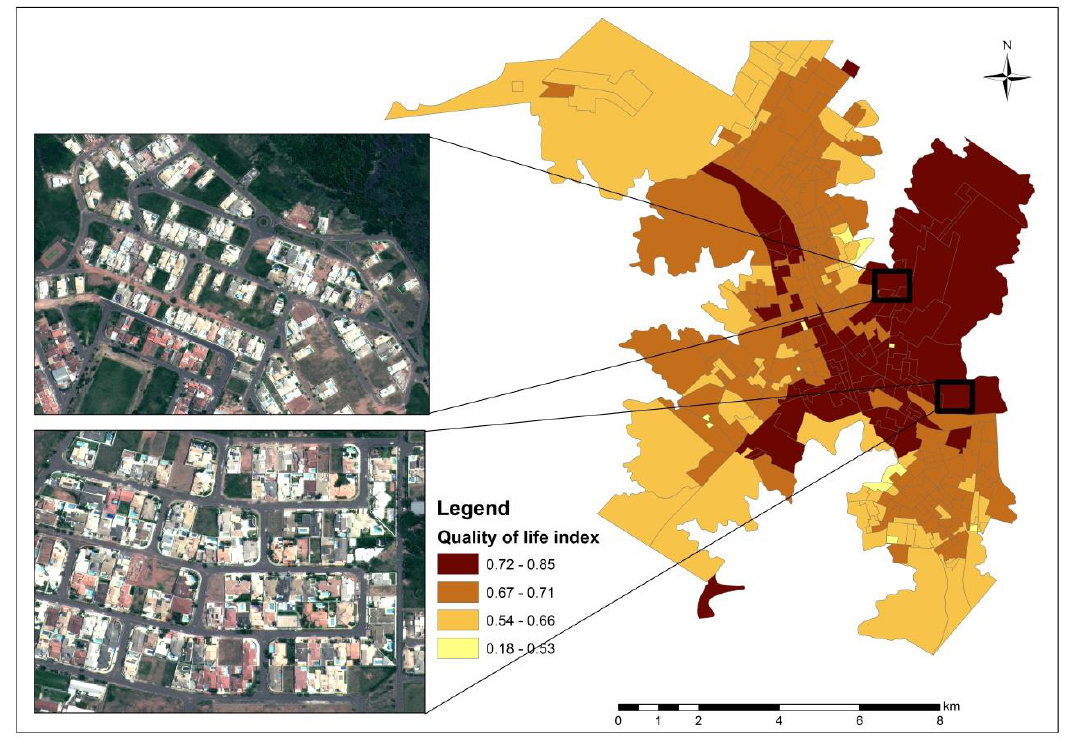
Figure 11. Illustration of the relationship among painted concrete slabs/light-colored roof tiles, pools, and the QOLI.